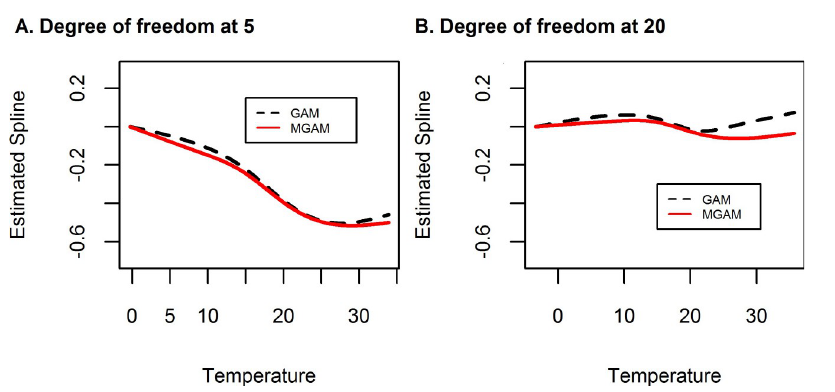
Fig 8. Estimated spline for temperature effect on AMI in Shanghai female residents aged 65+, 2007–2011.